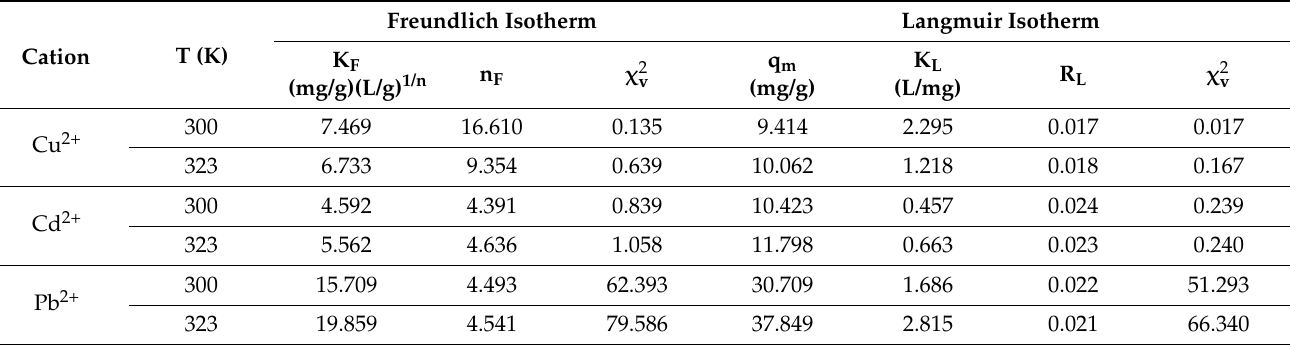
Table 3. Isotherm models and parameters for adsorption of Cu 2+ , Cd 2+ and Pb 2+ cations onto the oxidized wool fibers; experimental conditions: adsorbent dose = 0.5–9.0 g/L; C 0 = 50 mg/L; t = 240 min, pH 5.0 ±